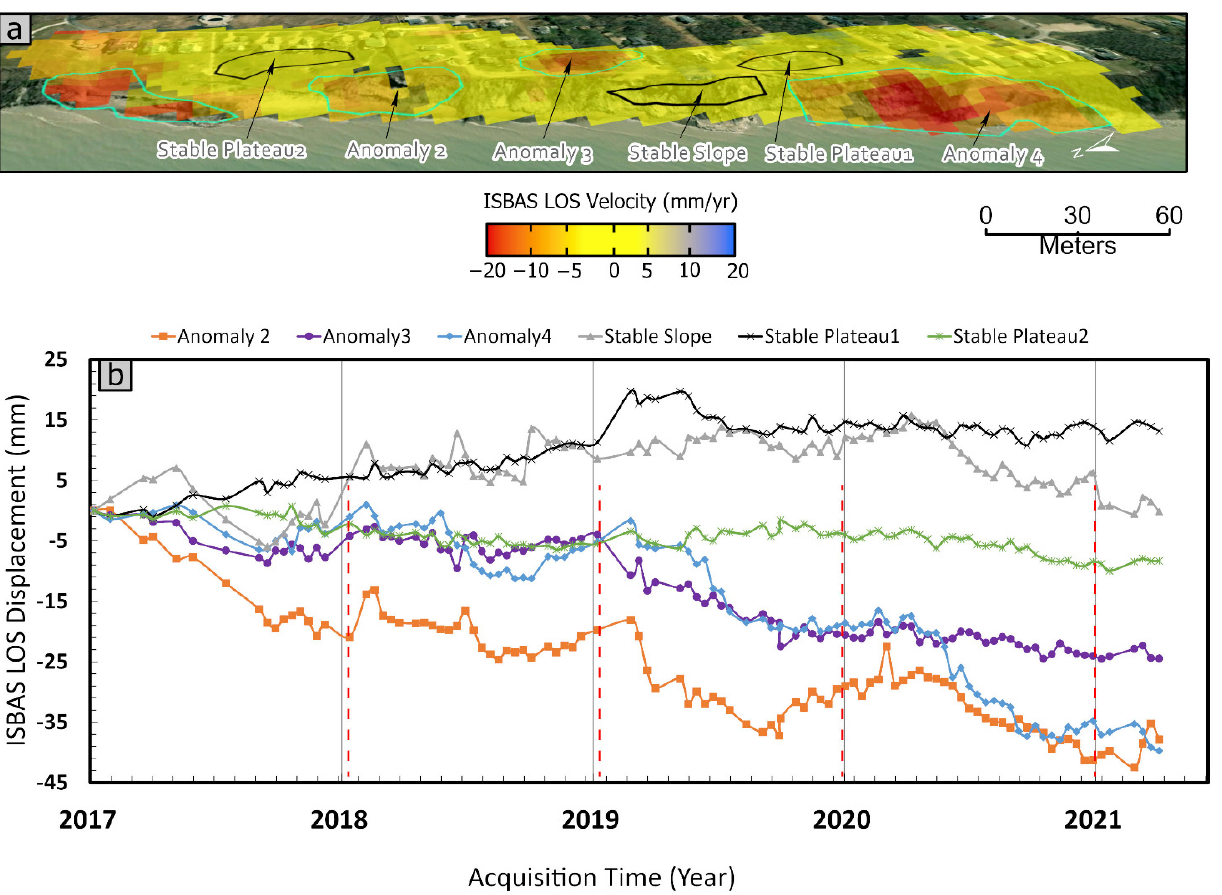
Figure 7. Spatial and temporal comparisons (between ISBAS LOS velocities for areas occupied by anomalies 2, 3, and 4 (green polygons) and those for interleaving areas along the bluff (stable slope) and over the plateau (stable plateau1, stable plateau2) outlined by black polygons. ( a ) ISBAS LOS velocity map over the study area draped over a DEM. ( b ) Cumulative LOS displacement time series. Anomalies 2 and 4 on the bluff face display both long ‐ term LOS displacement trends away from the satellite (subsidence) and seasonal cycles. Interleaving areas along the bluff (stable slope) show a weak seasonal cycle but no long ‐ term trends. Anomaly 3, located on top of the bluff, shows moderate subsidence, but it does not display seasonal cycles. Similarly, other stable inland areas (stable plateau1, stable plateau2) do not show seasonal cycles. Source of ArcGIS pro base map in Figure 7a: Esri, DigitalGlobe, GeoEye, i ‐ cubed, USDA FSA, USGS, AEX, Getmapping, Aerogrid, IGN, IGP, swisstopo, and the GIS User Community.